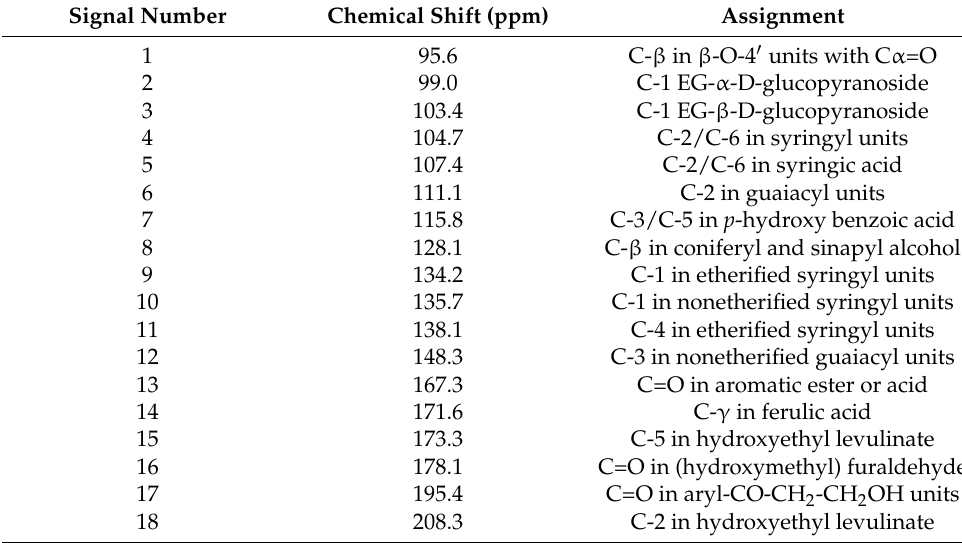
Table 6. Assignments of 13 C NMR signals in the region from 95.0 to 210.0 ppm for the W LGS -15 and W LGS -240 samples. Solvent: DMSO- d 6